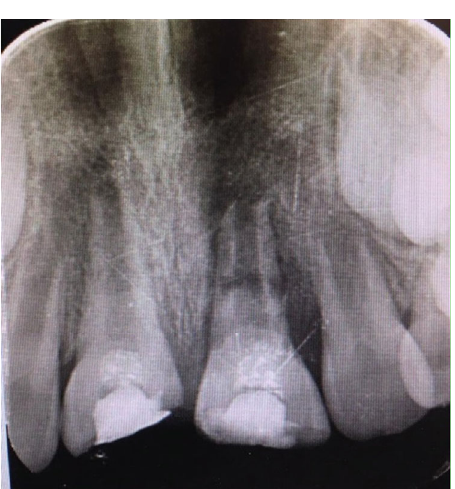
Figure 5: Follow-up after 8 weeks.